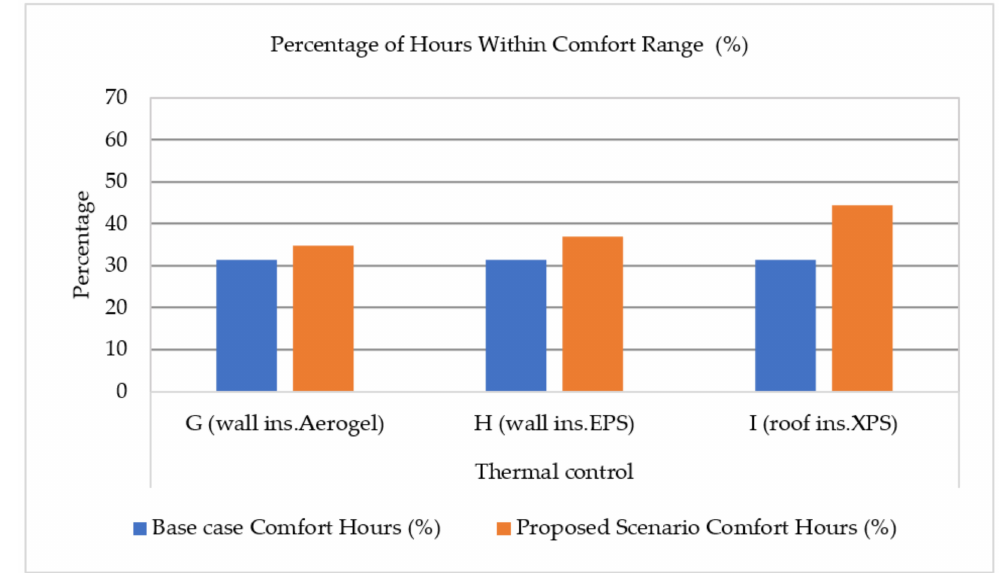
Figure 7. A comparison between the comfort hours in the base case and the proposed thermal control